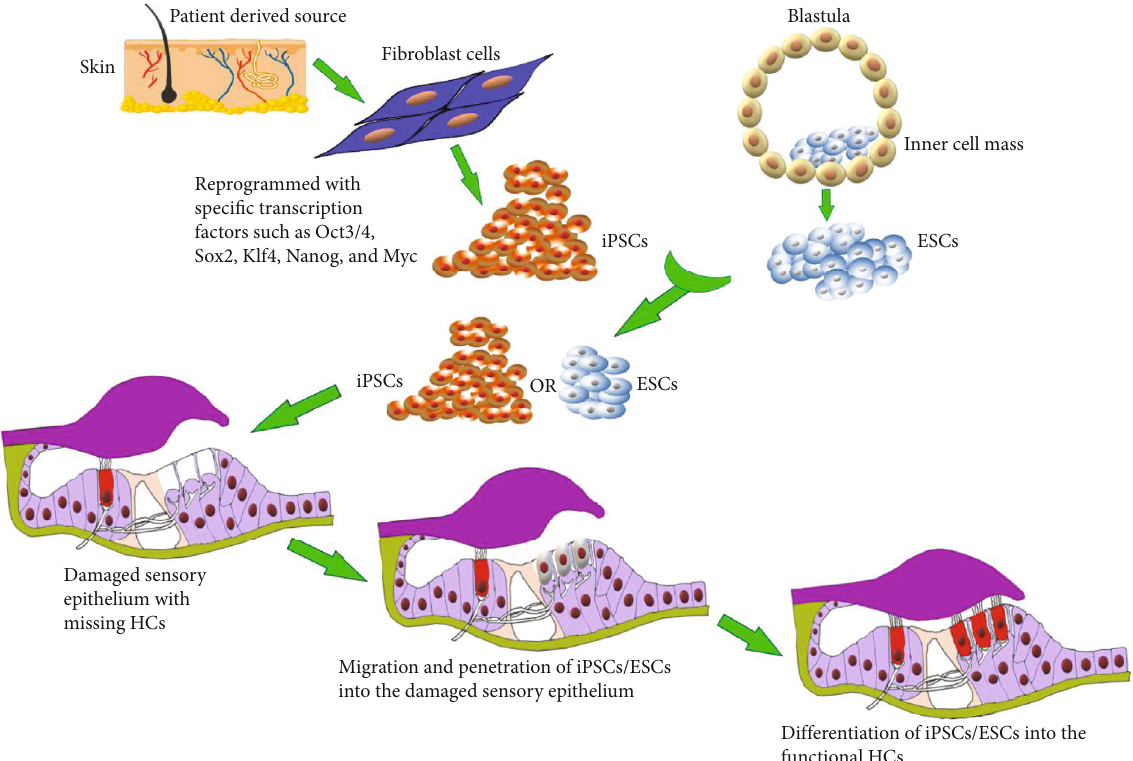
Figure 2: Schematic of the exogenous stem cell therapy showing the migration, penetration, and di ff erentiation of embryonic stem cells (ESCs) or inducible pluripotent stem cells (iPSCs) to generate functional HCs in the damaged sensory